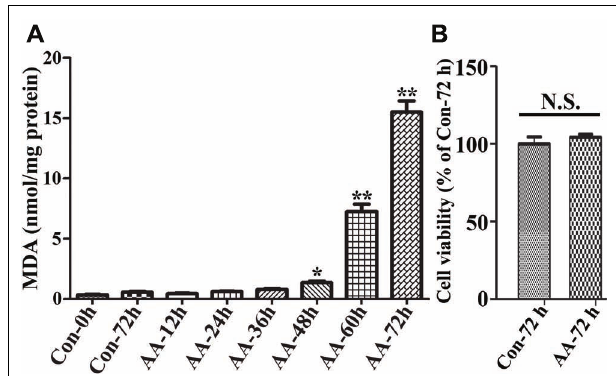
FIGURE 2 |Time-dependent induction of LPO in RA-differentiated, non-induced 3D5/DAT cells byAA treatment. 3D5/DAT cells with 8 days of RA-elicited differentiation and without α -syn induction were treated with AA for 12, 24, 36, 48, 60, and 72 h, referred to as AA-12h, AA-24h, AA-36h, AA-48h, AA-60h, and AA-72h, respectively, or without for 0 and 72 h (Con-0h, Con-72h).They were harvested and used for (A) LPO assay to determine MDA levels per mg protein. (B) Sibling cultures of AA-72h and Con-72h were used for Calcein AM assay to assess cell viability. Bar graphs summarized data derived from three independent experiments using different sets of cultures.The levels of LPO detected in cultures with 48, 60, and 72 h of AA exposure were 3, 19, and 40 times of that in Con72h cultures, and the differences are statistically significant. Error bars represent standard errors of the mean (SEM). (* p < 0.05 and ** p < 0.01 comparing to Con-0h, n = 3) In contrast to that displayed by LPO assay, there was no significant difference between cultures with and without 72 h of AA exposure in regard to their